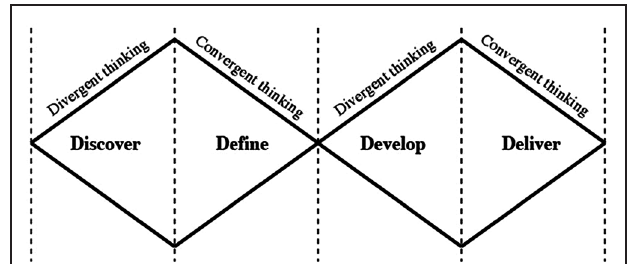
FIGURE 1 | The Double Diamond (DD)